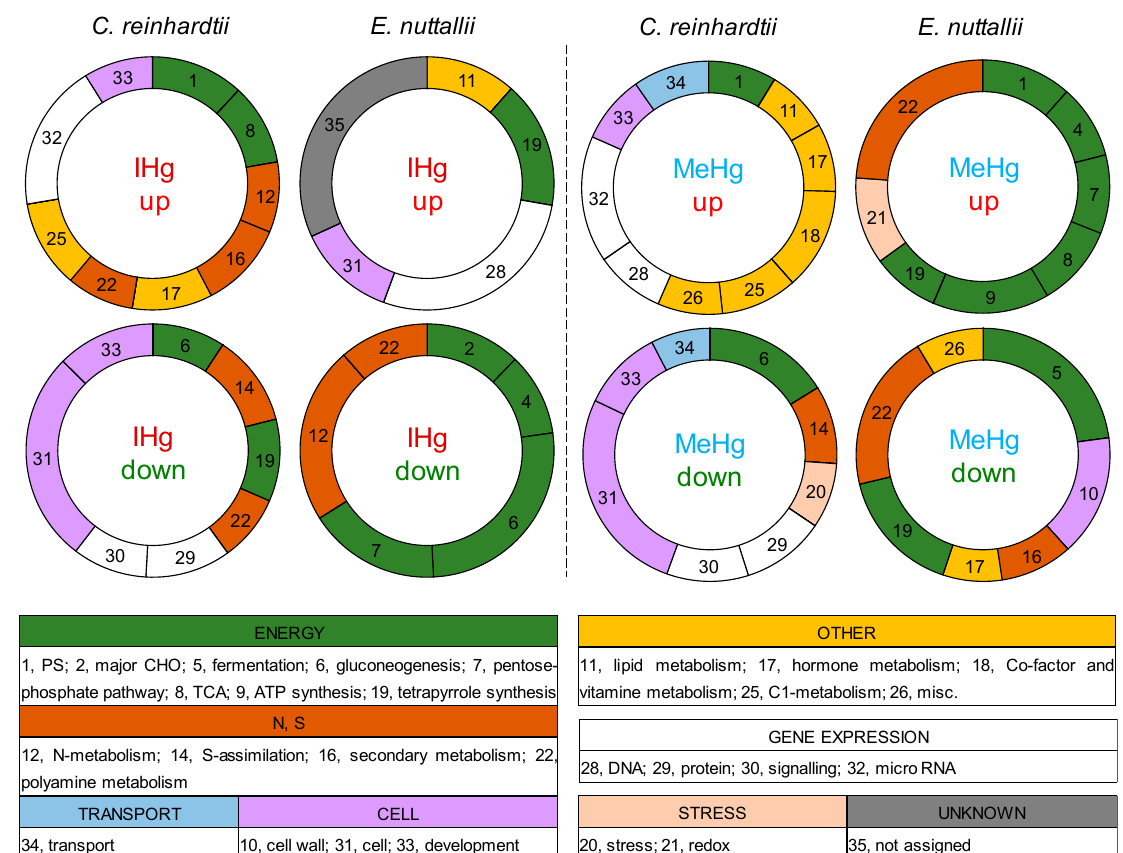
Figure 4. Distribution of the top functional categories up- or down- regulated by IHg (10 − 8 M IHg for C. reinhardtii and E. nuttallii ) or MeHg (common genes all MeHg treatments for C. reinhardtii , common 10 − 8 and 10 − 9 M MeHg for E. nuttallii ) in C. reinhardtii or E. nuttallii . Gene numbers were normalized by the total number of genes assigned to a category in the whole